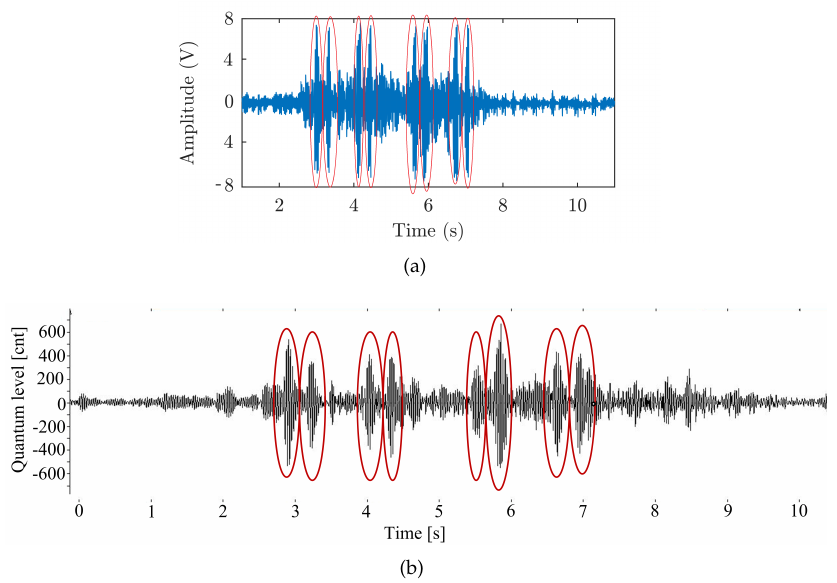
Figure 11. ( a ) Time record of the passing tram measured by the interferometric sensor; ( b ) time record (original report) of the passing tram measured by the seismic station.